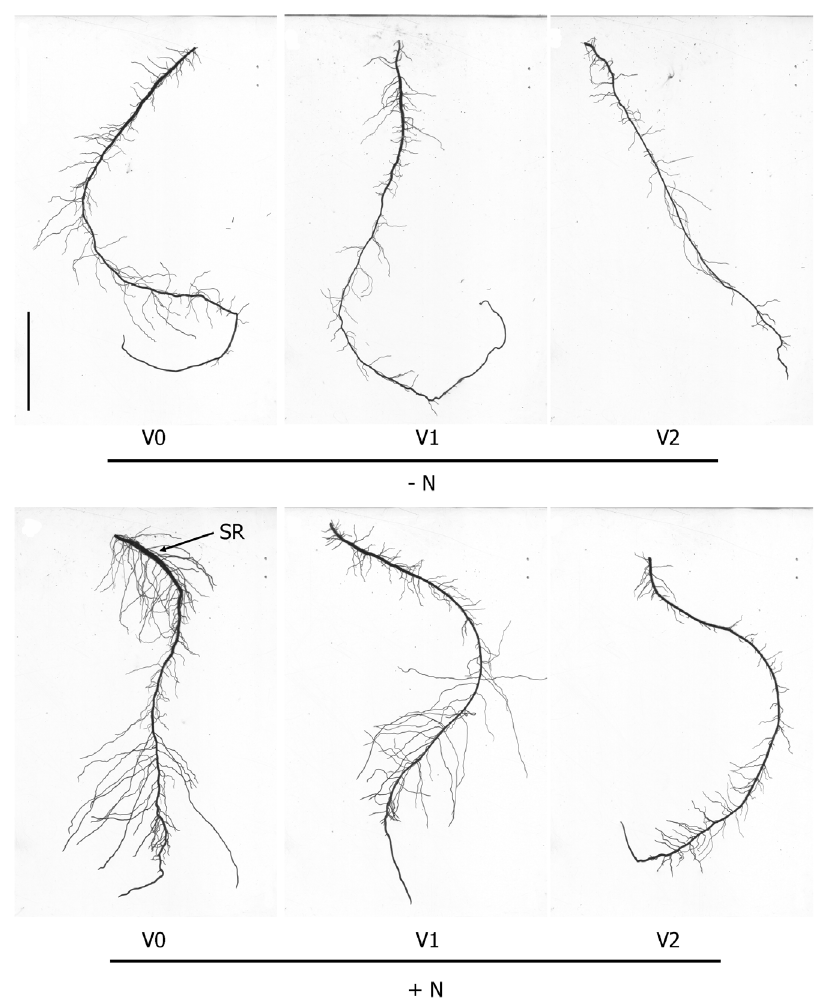
Figure 3. Representative adventitious roots from sweetpotato ‘Beauregard’ plants subjected to different virus treatments and grown with or without nitrogen. + N = nitrogen provided as KNO 3 , - N=no nitrogen provided. V0 = plants derived from non-inoculated, virus- tested plant stock; V1 = plants derived from V0 plant stock graft inoculated with the potyvirus complex (SPFMV, SPVG, SPVC, and SPV2); V2 = plants derived from plant stock infected with SPCSV. SR=localized swelling indicative of successful storage root initiation. Scale bar =5 cm.